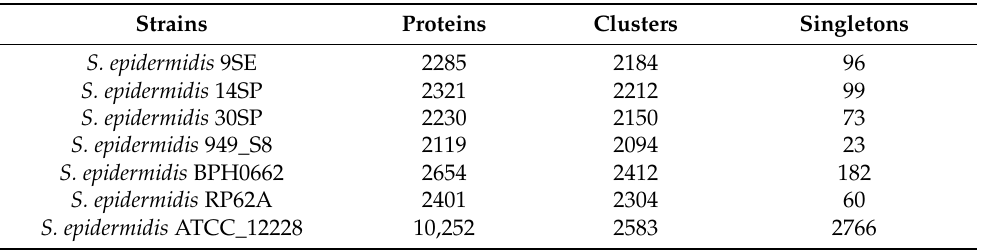
Table 2. Summary of orthologous clusters and single-copy gene clusters of isolated reference strains of S. epidermidis.